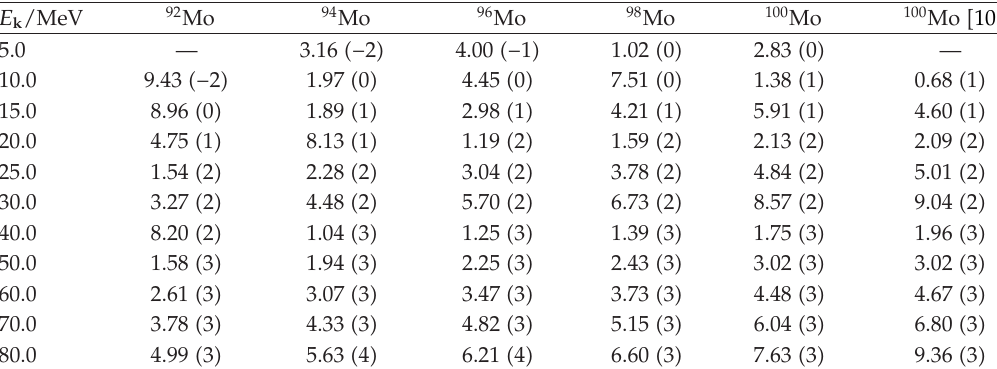
Table 1: Cross sections for the charged-current neutrino-nucleus scattering o ff the even molybdenum nuclei in units of 10 − 42 cm 2 . Exponents are shown in parenthesis. In the last column, we also show for comparison the results for 100 Mo calculated in (cid:5) 10 (cid:6) .